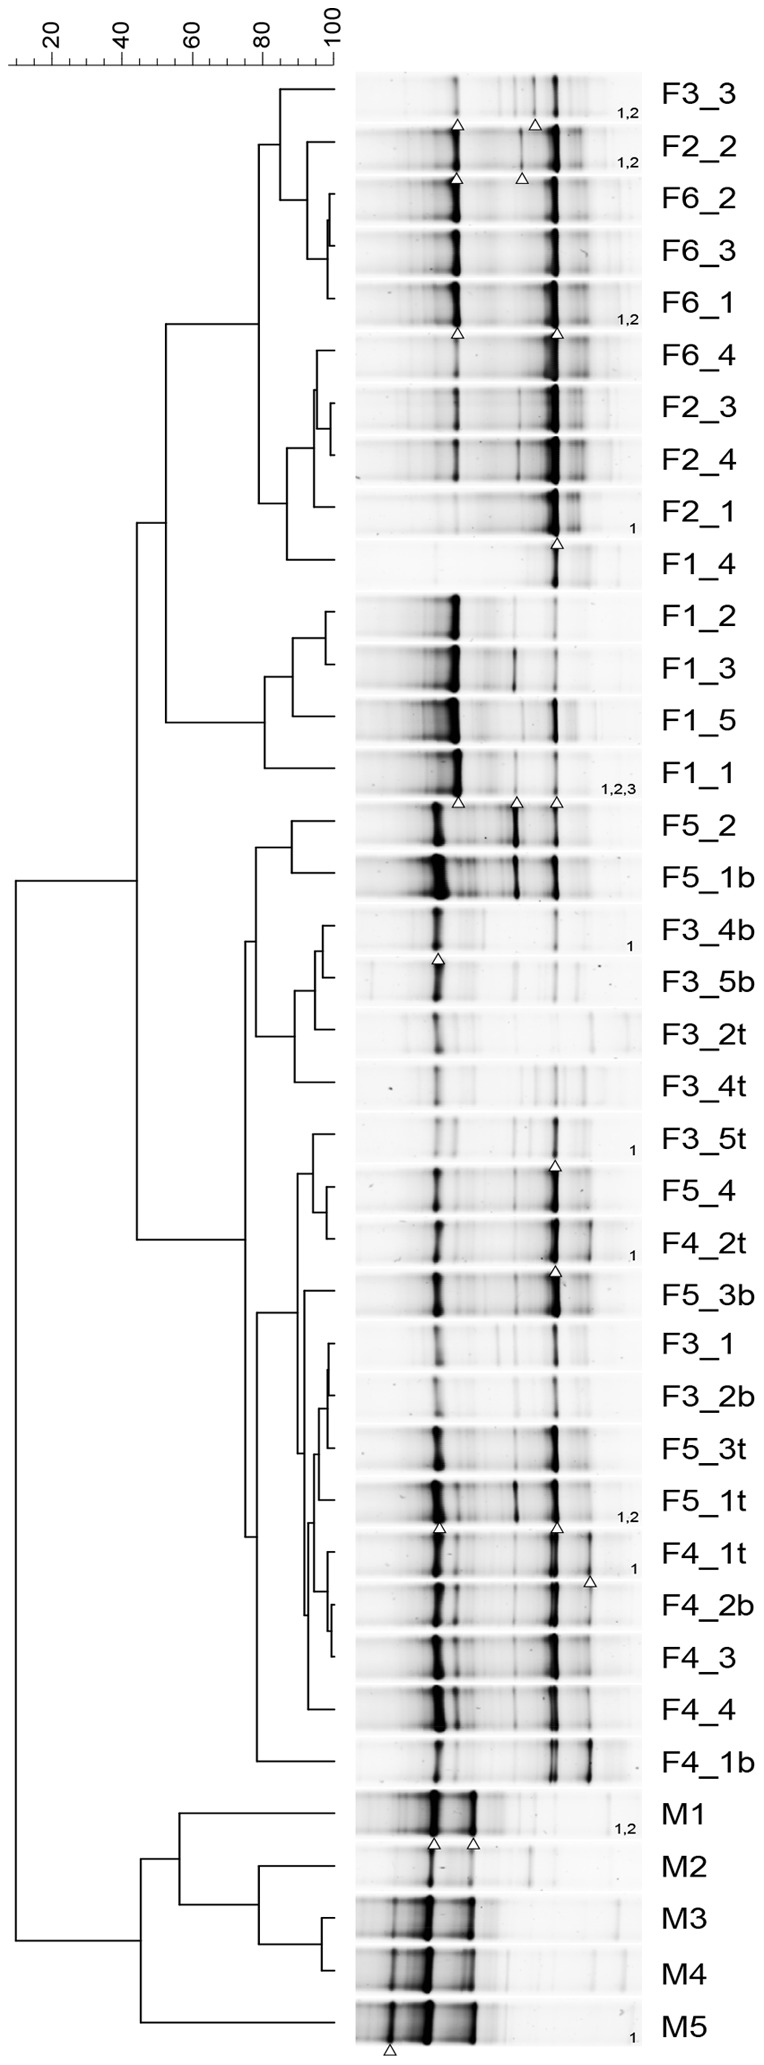
Denaturing gradient gel electrophoresis of thaumarchaeal 16S rRNA gene amplicons from freshwater (F1–F6) and marine (M) aquarium, with an unweighted pair group method with arithmetic mean (UPGMA) dendrogram representing distances based on Pearson correlations of fingerprint densitometric curves.Fingerprints have been normalized and aligned. Bands chosen for sequencing are indicated with triangles and numbering on the right side of lanes.